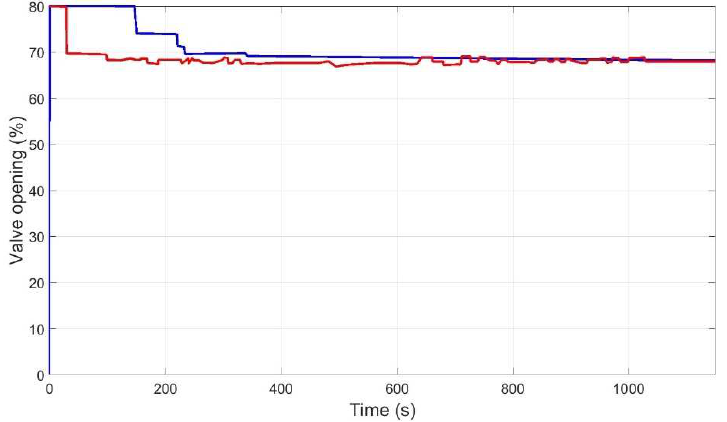
Figure 18. Evolution of valve opening control action to reach the representative operating point (P_ref = 2 bar, Q r _ref = 54 L/h) using inverse local models (blue), and expert control based on fuzzy logic (red).